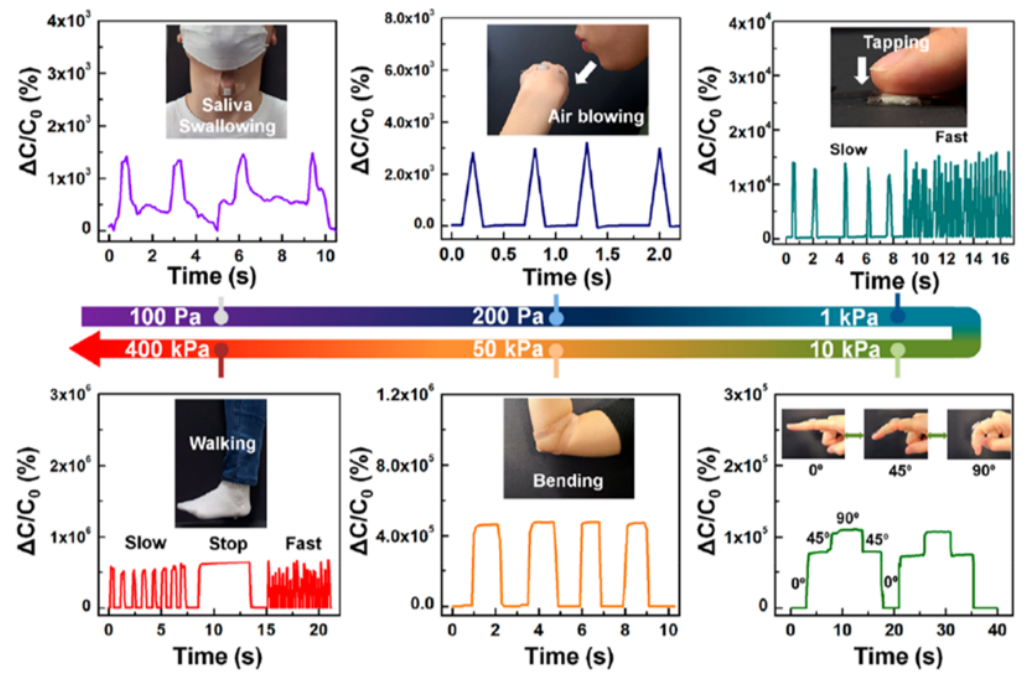
Figure 8. Real-time monitoring of human motions in different magnitudes of pressures based on nanopore ion gel. Reprinted from [65], copyright (2021) with permission from American Chemical Society.